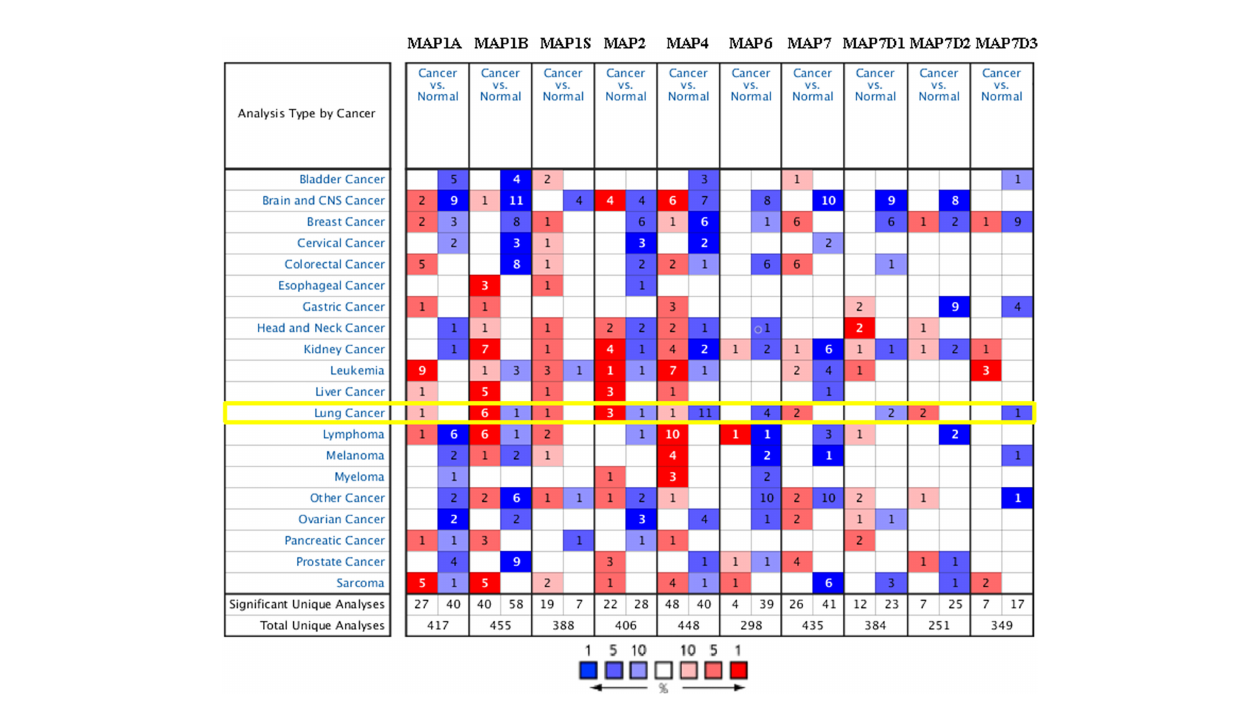
FIGURE 1 | Transcriptional expression of MAPs in 20 types of tumors (Oncomine database). Differences in mRNA levels of MAPs were compared by Student ’ s t-test. Cutoffs of p-value and fold change of expression levels were as follows: p-value: 0.01, fold change: 1.5, gene rank: 10%. MAP, microtubule-associated protein.